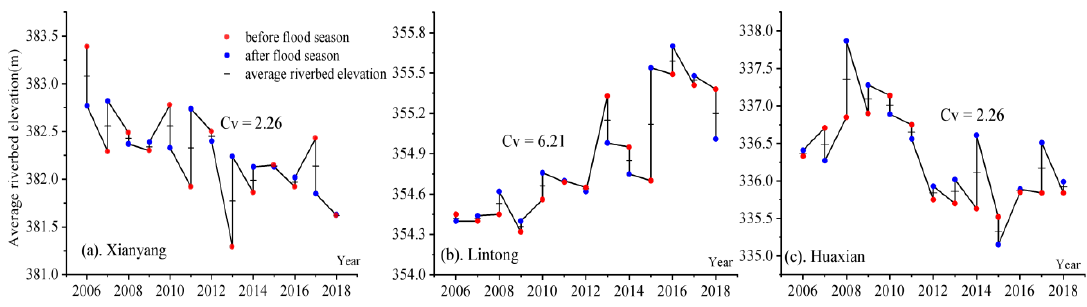
Figure 7. The average elevation of the main channel of the: ( a ) Xianyang station; ( b ) Lintong station; and ( c ) Huaxian station before and after the floods in 2006–2018. Table 1. Mean elevation changes of hydrological stations in the lower Weihe River during the flood and non-flood periods in 2006–2018. Unit: